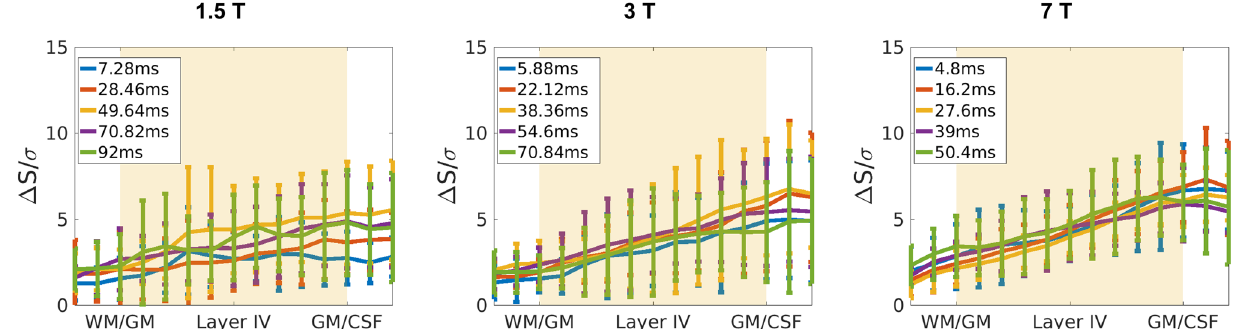
Figure 6. Functional CNR profiles at 1.5 T (left), 3 T (middle) and 7 T (right). The signal change upon activation (∆S), is divided by the standard deviation over time of the signal in the resting condition, σ. Profiles correspond to average ± std over subjects for different echo times (5 out of 10 echo times shown for visualization purposes). The CNR values in the middle of the parenchyma are not significantly different between 3 and 7 T (p-values ≥ 0.03, threshold corrected for false discovery error